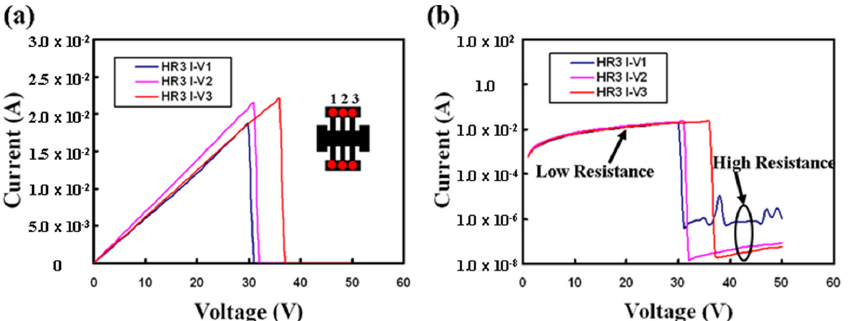
Figure 6. ( a ) Linear and ( b ) log ‐ linear I ‐ V characteristics of three generated HR paths for the flexi ‐ ble PR strain sensor.